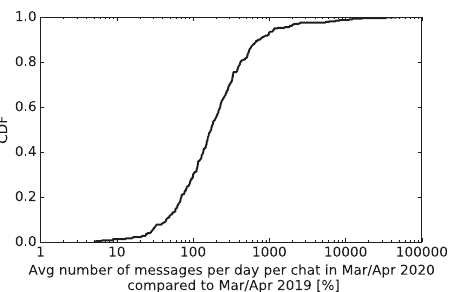
Fig. 4 Share of media for each period. The fi gure shows the share of sent media messages (e.g., images, video, and gifs) in the pre-pandemic period (left) compared to the pandemic